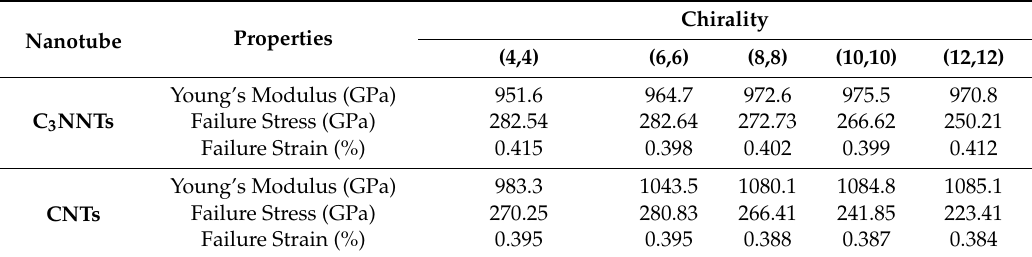
Table 2. Mechanical properties of armchair SWC 3 NNTs and SWCNTs under uniaxial tensile tests at 300 K.